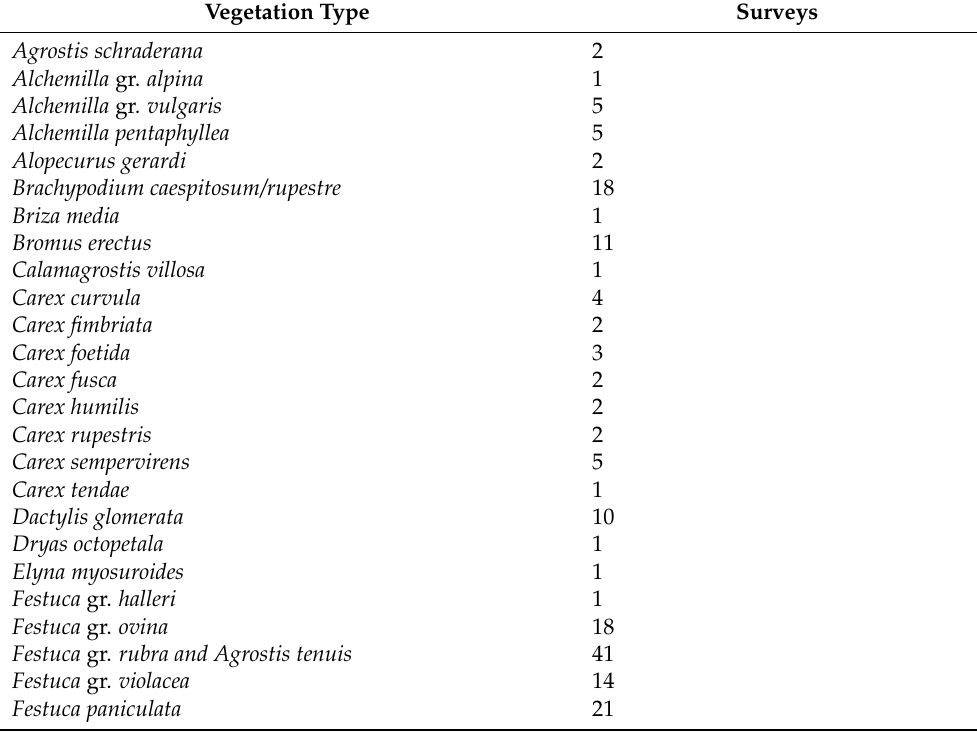
Table A1. List of vegetation types ( sensu Cavallero et al. [12]) surveyed in the 324 pastures. The dominant plant species and the number of surveys performed per each vegetation type is